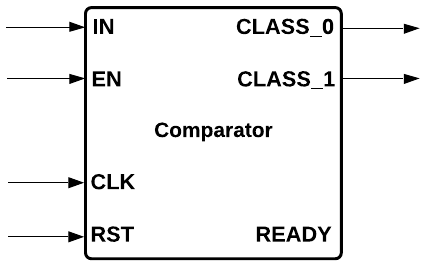
Figure 6. Comparator Module of MLP and Logistic